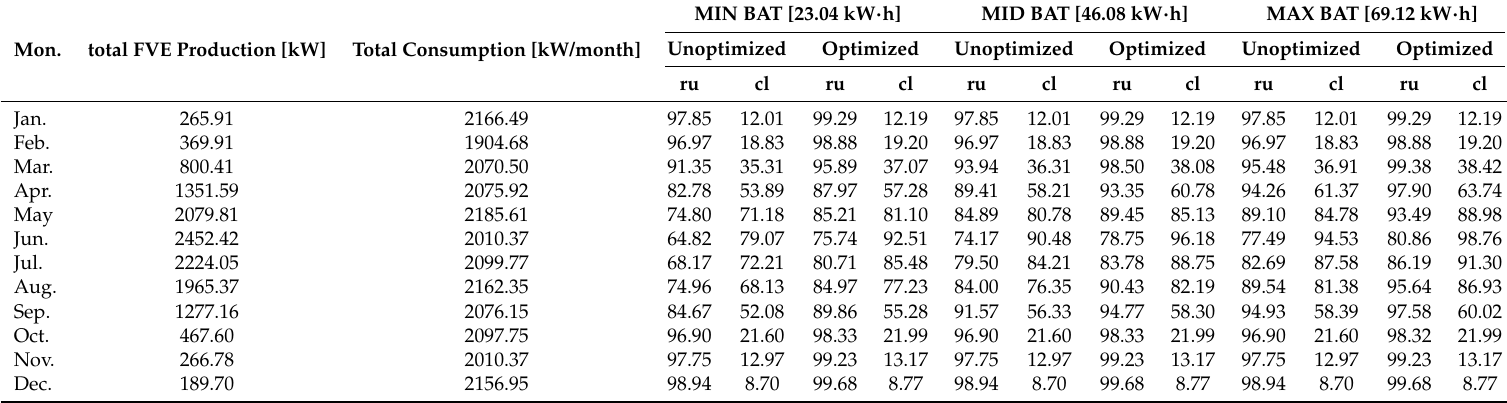
Table 5. Energy savings acquired for different system configurations having optimized and unoptimized simulations. Shortcut ’ru’ means percentage of renewable energy used and ’cl’ means the percentage of covered load by RES. Outcomes in this table were computed on lower charging scenario—taking the current